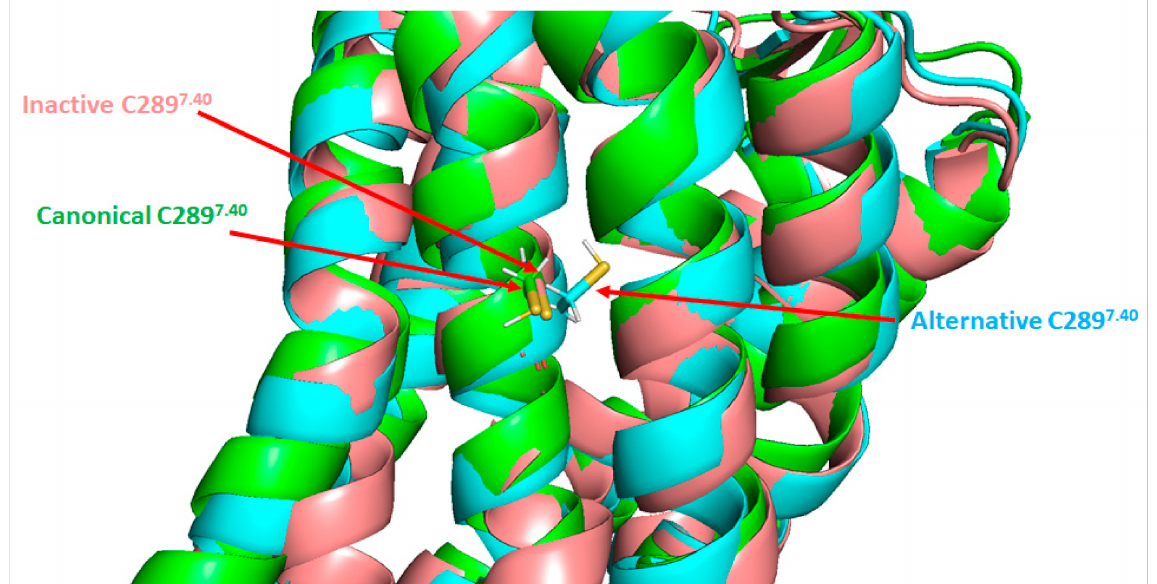
Figure 7. Positions of the cysteine 289 residue in the three known AT 1 structures. Superimposition of the three known AT 1 structures: inactive (salmon), canonical active (green) and alternative active (cyan). TM6 and TM7 are located in the front. C289 residue is indicated by arrows. The reference inactive structure of AT 1 has been chosen as PDB code 4YAY (from Zhang et al. [99]). Canonical active and alternative active structures are simulation data available in supplementary material from Suomivuori et al. [98]. The figure was prepared with the PyMOL software (The PyMOL Molecular Graphics System, Version 2.5.0. Schrödinger,